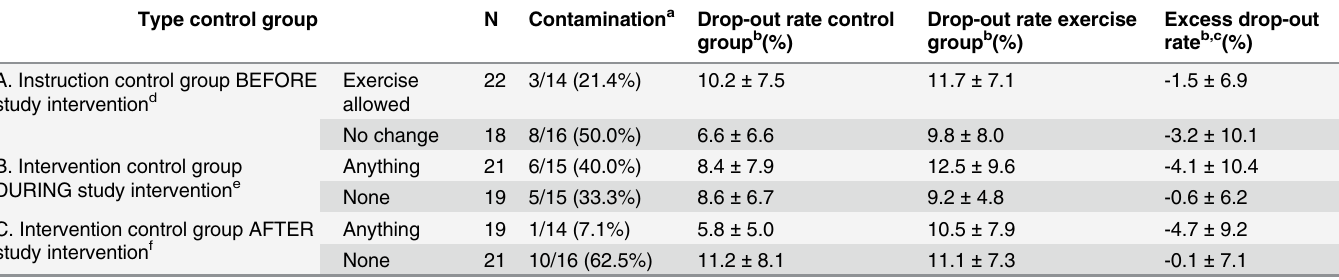
Table 2. Contamination and drop-out rate by type of control group.